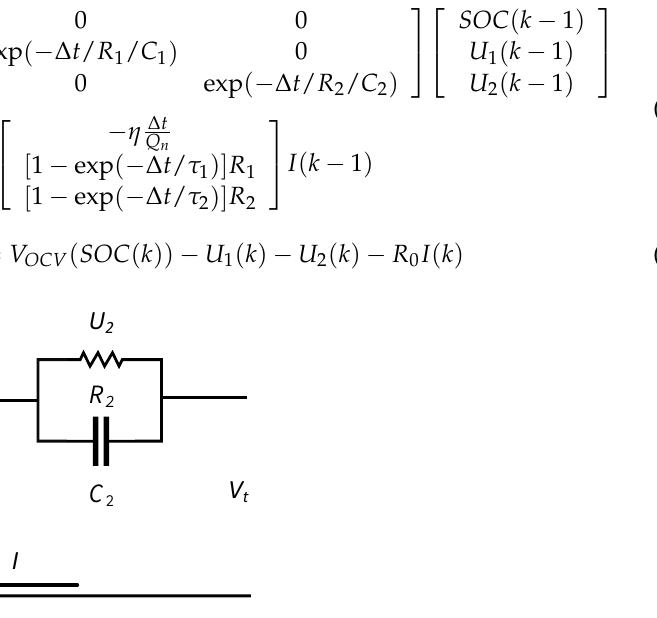
Figure 1. Schematic diagram of the two-order RC ECM.